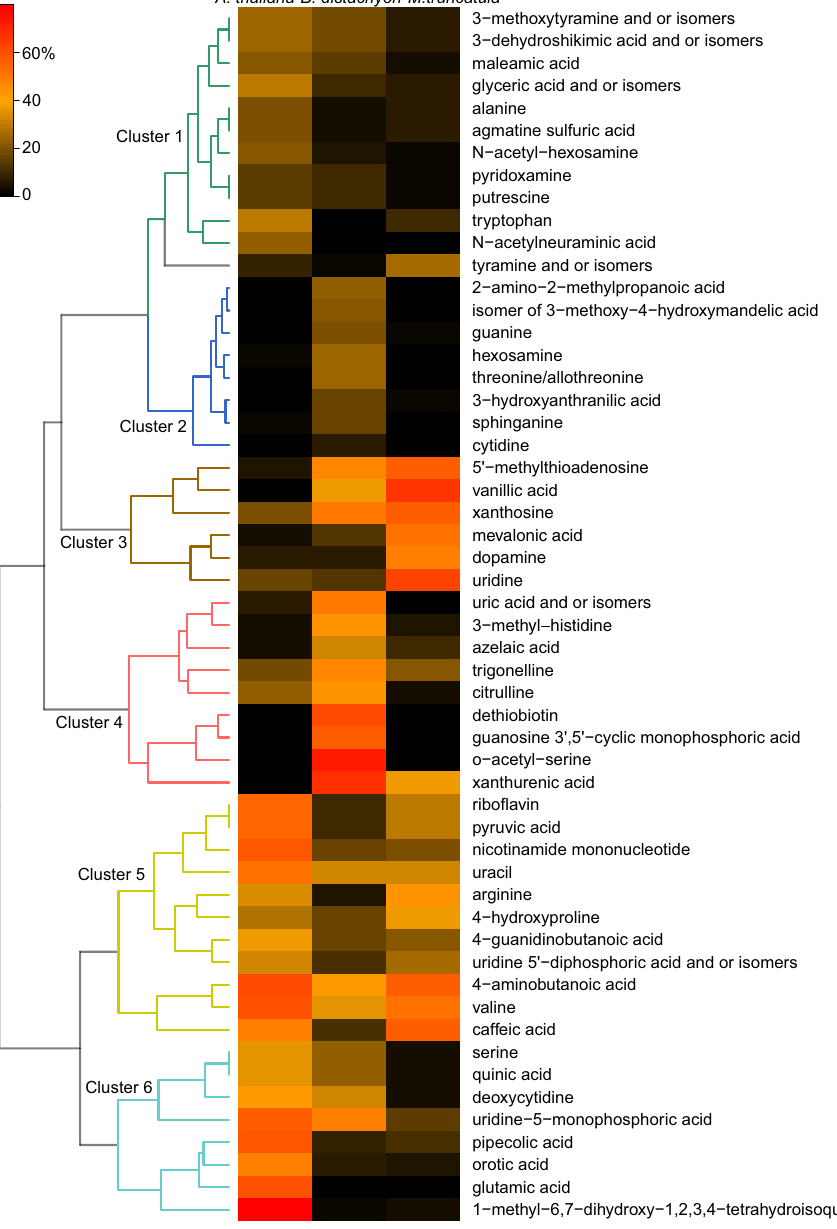
Fig. 4 | Species-speci fi c patterns of root metabolites. Heatmap of root metabo- lites. Each cell represents an averaged value of normalized peak height of meta- bolites signi fi cantly different between plant species (Anova, p <0.05 and post-hoc Duncan ’ s multiple range test). Hierarchical clustering identi fi ed six clusters of